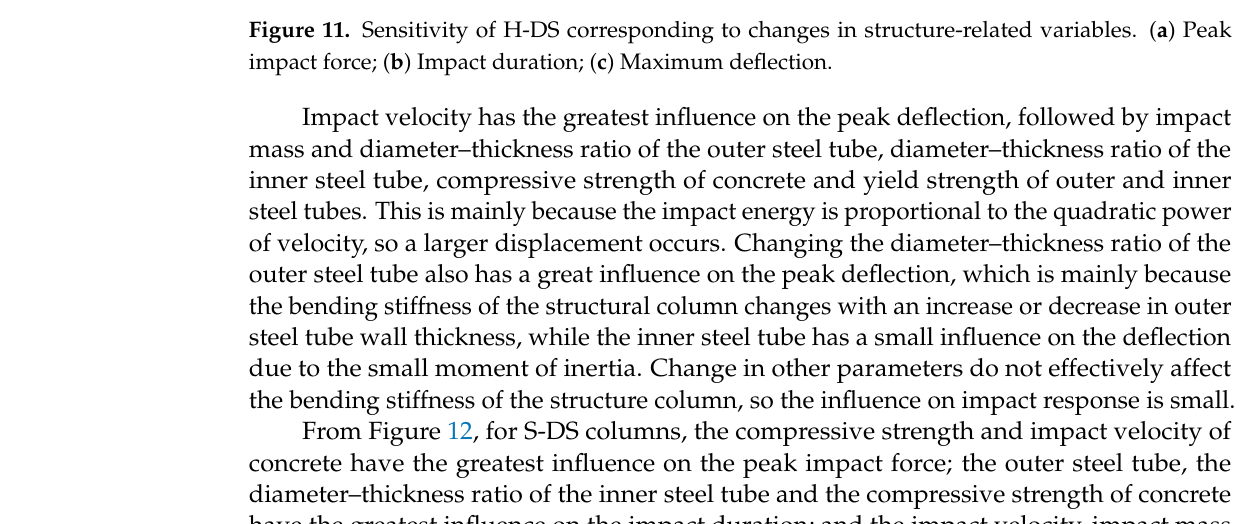
Figure 12. Sensitivity of S-DS corresponding to changes in structure-related variables. ( a ) Peak impact force; ( b ) Impact duration; ( c ) Maximum deflection.